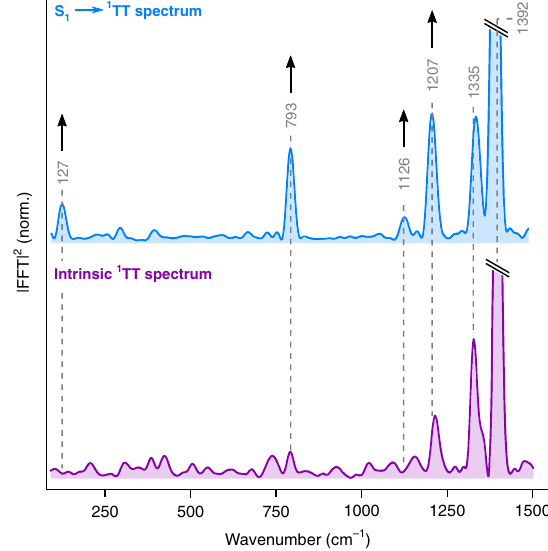
Fig. 3 Identi fi cation of transferred coherence. Comparison of impulsive Raman spectra directly generated in 1 TT (bottom, purple) and transferred from S 1 via singlet fi ssion (top, blue, reproduced from Fig. 2). Experimental spectra are normalised to the high-frequency peak at 1392 cm − 1 , which is truncated for clarity. Arrows indicate regions where singlet fi ssion increases the peak (coherence) intensity. Dashed vertical lines are a guide to the eye indicating the dominant vibrational